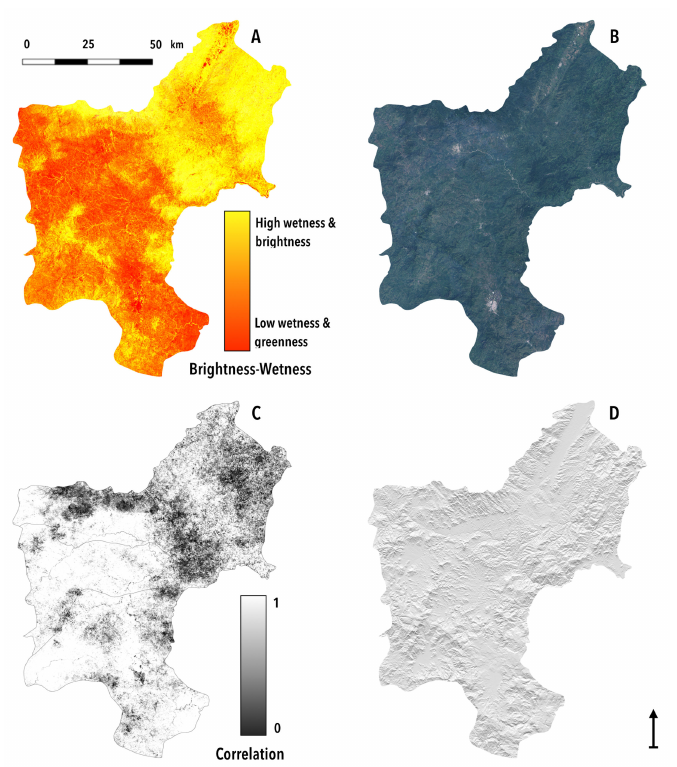
Figure 3. ( A – D ) Datasets used for land-cover classification. ( A ) Seasonal image composite spanning dry hot months (January–April), visualized using derived brightness, greenness, and wetness bands. ( B ) Seasonal image composite spanning dry cool months (November–December), visualized in natural color composite using red, green, and blue spectral bands. ( C ) Correlation matrix of precipitation and NDVI on a 30-day lag. ( D ) Hillshade derived from Shuttle Radar Topography Mission (SRTM) data. Data are presented for the three study districts. Coordinates from west to east: − 86.8 ◦ to − 85.8 ◦ . Coordinates from south to north: 12.8 ◦ to 14.1